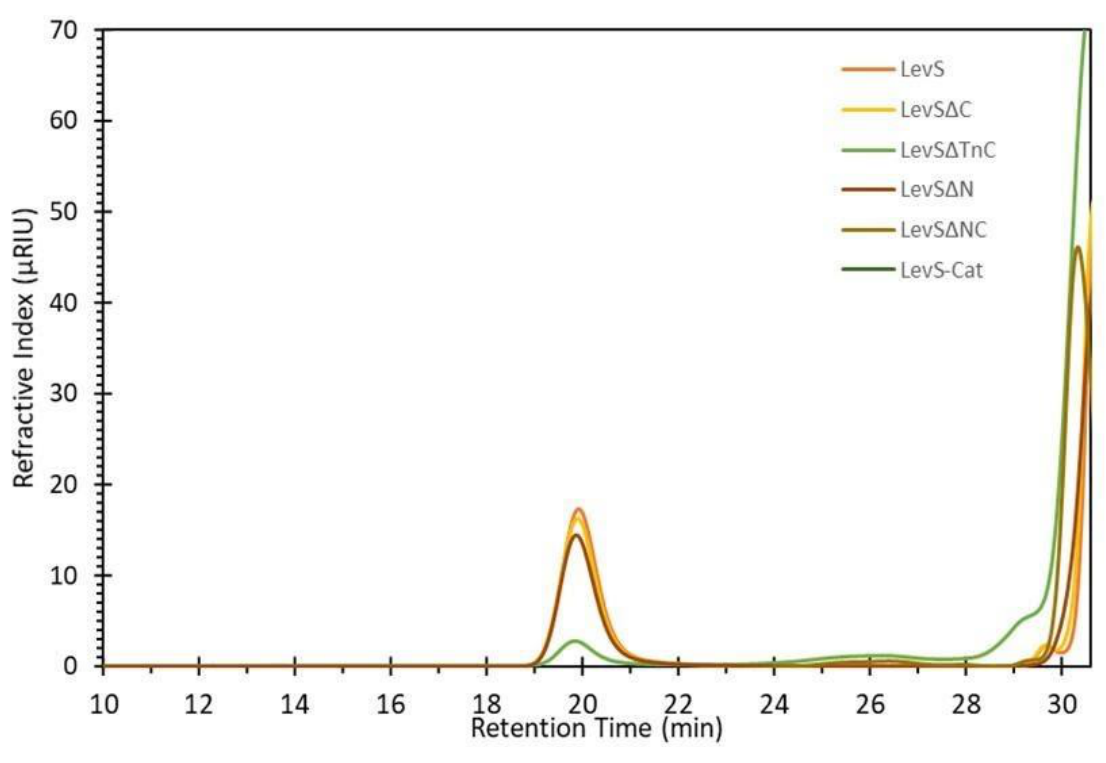
Figure 4. HMW polymer profile obtained from sucrose by LevS and truncated versions. Reaction conditions: enzyme 1.0 U/mL, sucrose 292 mM, pH 6, 30 °C.